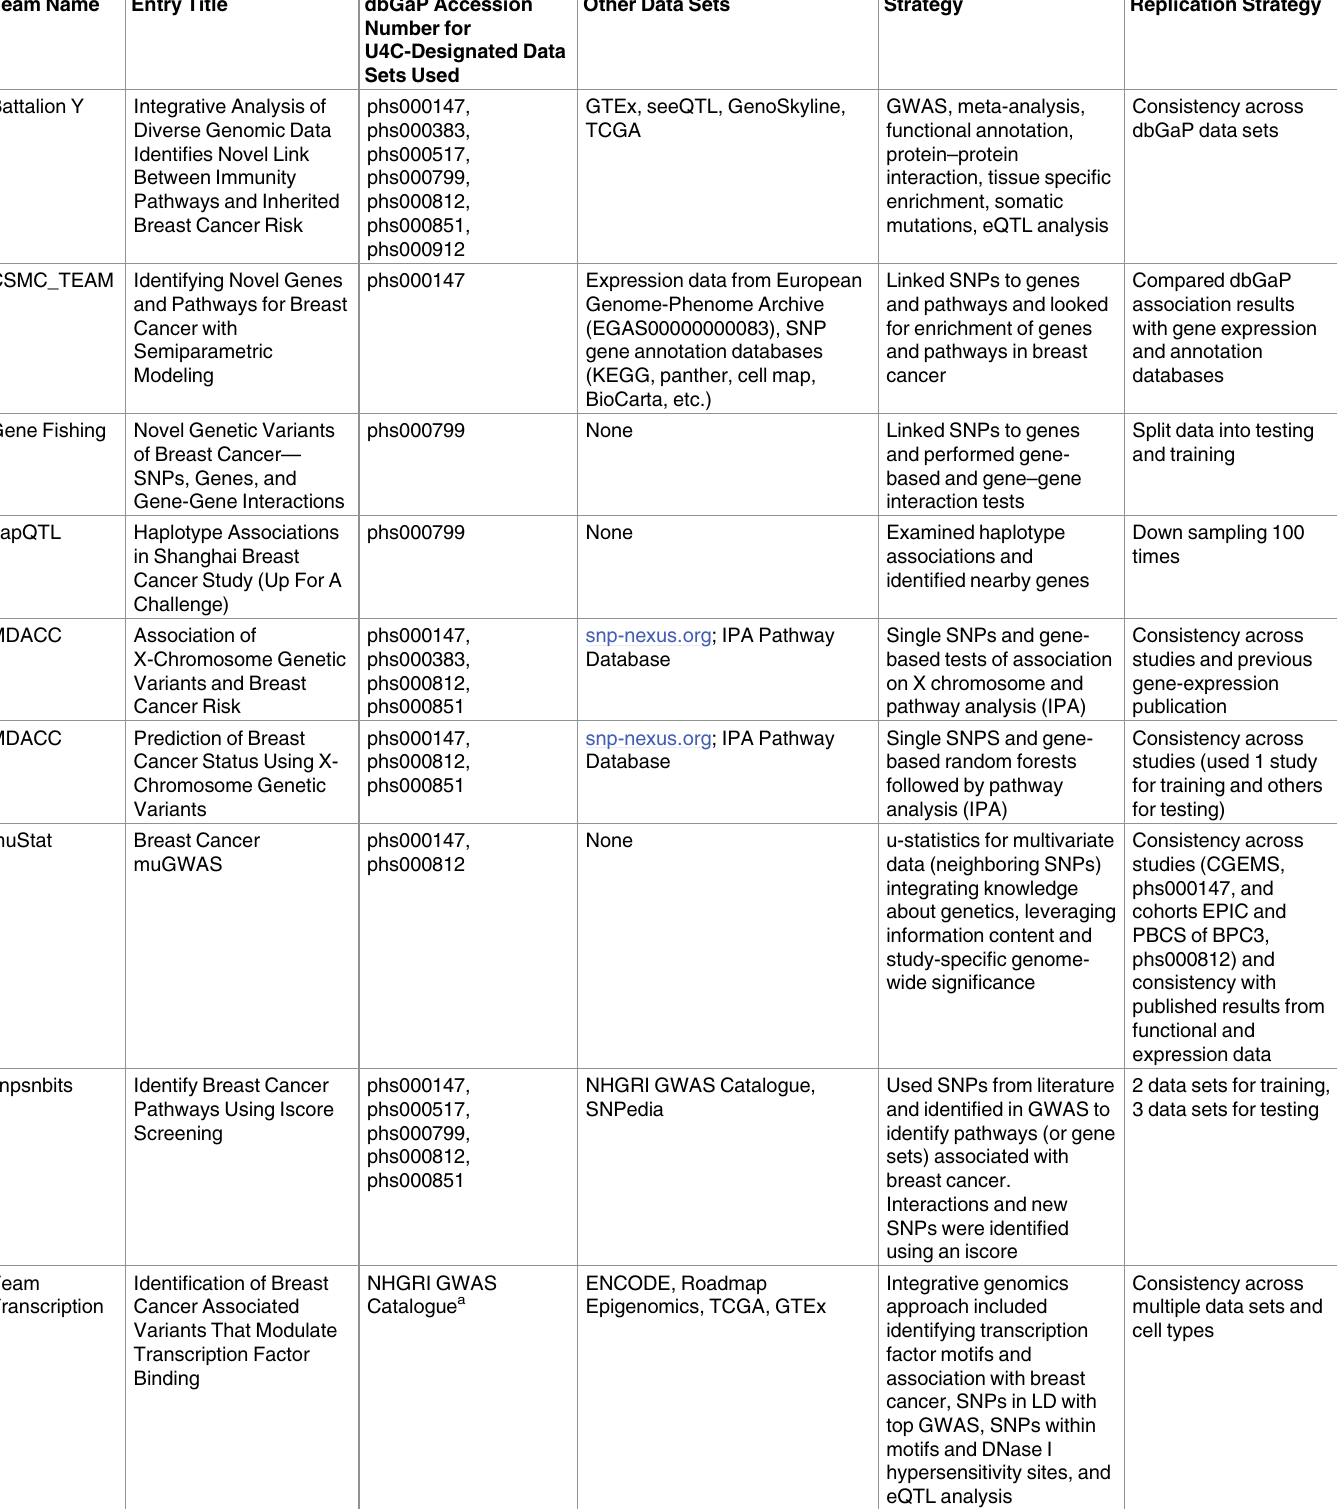
Table 1. Overview of U4C